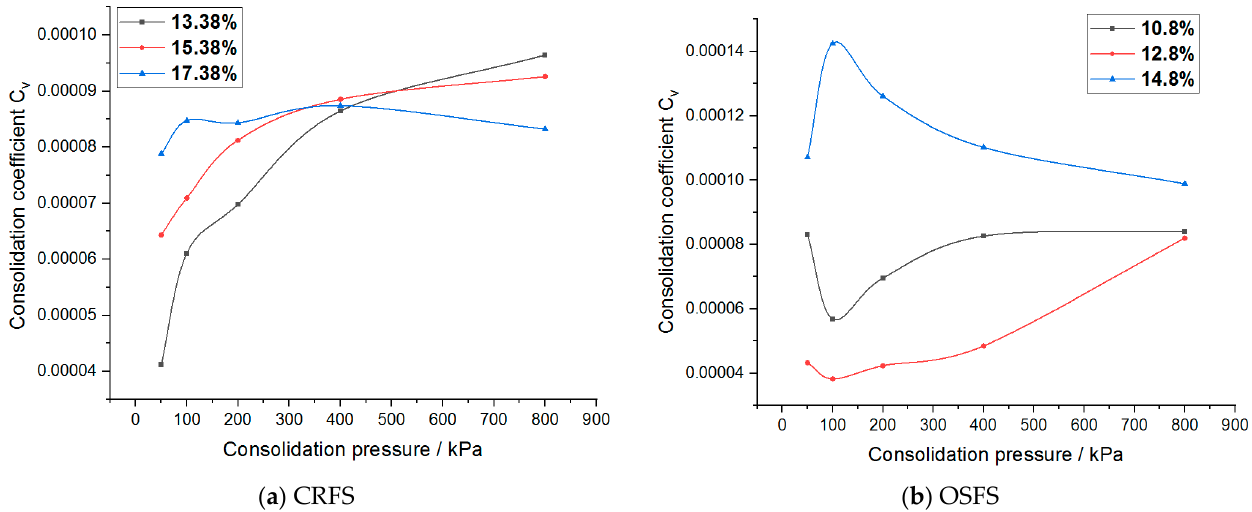
Figure 18. Consolidation coefficient of modified soil with different water contents.